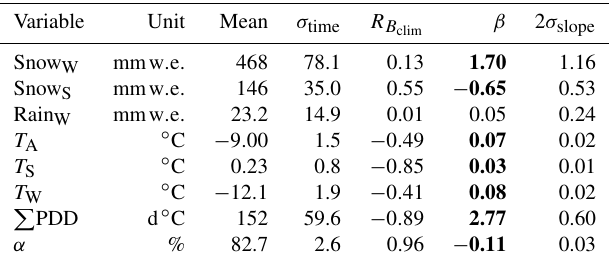
Figure 8. Modelled energy fluxes (Wm − 2 ) averaged over all glaciers and each year’s melt season (15 May–30 September) for the period 1957–2014. Area averaging was performed based on each year’s glacier mask. Table 6. Glacio-meteorological variables averaged over all glaciers in Svalbard and the period 1957–2014 separated into: annual, melt season (15 May–30 September) and accumulation season (1 Oc- tober to 14 May) which are indicated by subscripts: A, S and W respectively. σ time is 1 standard deviation of the temporal variabil- ity, R B is correlation with annual B clim , β is the estimate of clim a linear trend, while σ slope is slope uncertainty given by 2 stan- dard deviations. Slope significance at the 95% level in bold font ( | β | > 2 σ slope ). Snow and rain is seasonal solid and liquid precipita- tion respectively. T is air temperature 2m above the surface, P PDD is cumulative positive degree days calculated from T A and α is the melt season albedo.